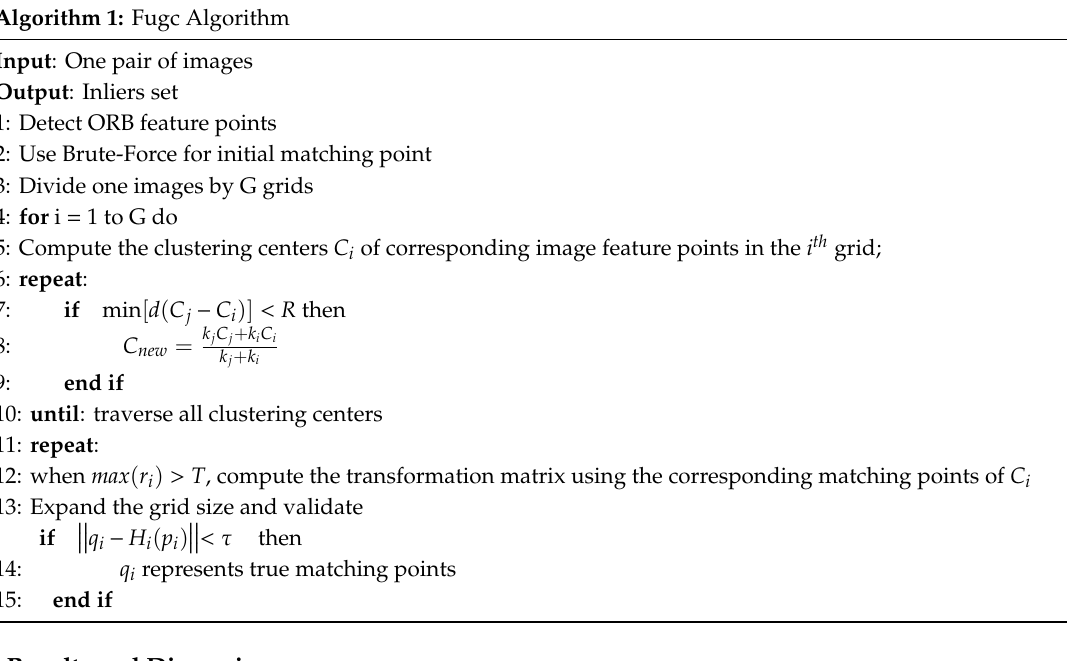
Figure 8. Feedback verification results of FUGC matching. ( a ) Feedback verification results after grid expansion. ( b ) Final matching result of the FUGC method.